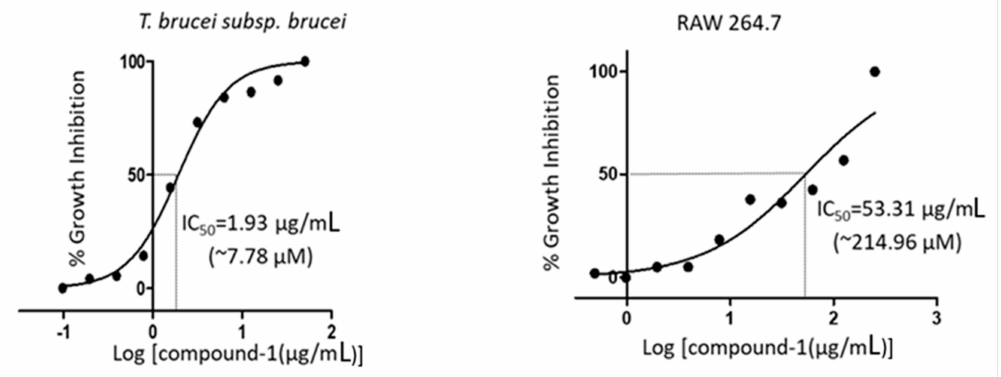
Figure 3. Dose-response curves for compound 1 : IC 50 values were calculated from Alamar blue cell viability assays in both T. brucei subsp. brucei and mouse macrophages RAW 264.7 cell lines. Selectivity index (SI = 27.62) was calculated as a ratio of the IC 50 in T. brucei to that in RAW 264.7 cell lines.